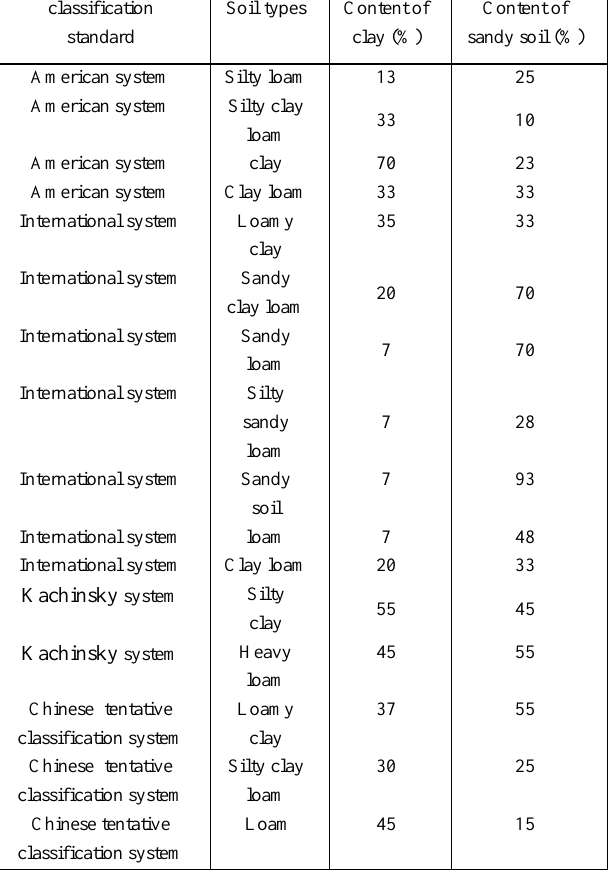
Table 1 . The employed dataset corresponds to different soil classification standards.